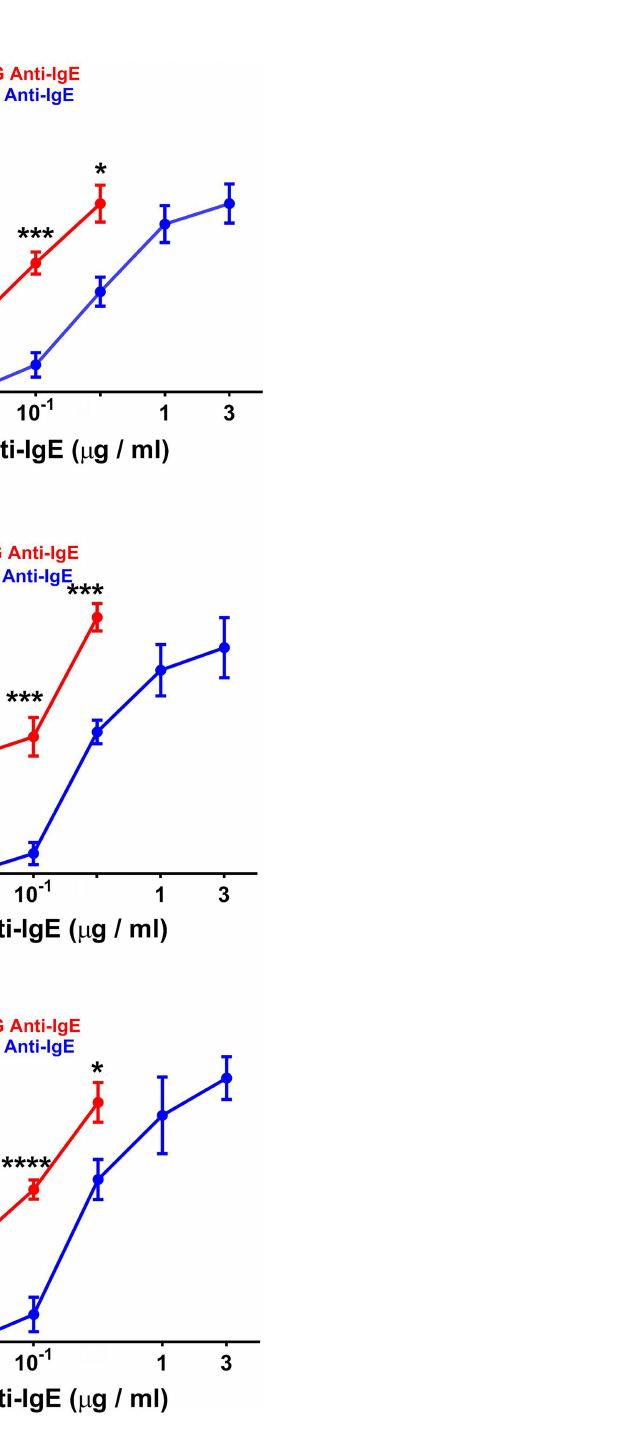
FIGURE 5 | Effects of increasing concentrations of human IgG anti-IgE and rabbit IgG anti-IgE on HR (A) and the de novo synthesis of LTC 4 (B) and PGD 2 (C) from HLMCs obtained from fi ve different donors. HLMCs were incubated (45 min at 37°C) in the presence of the indicated concentrations of human IgG anti-IgE or rabbit IgG anti-IgE. Each point shows the mean ± SEM. **** p < 0.0001, *** p < 0.001, * p < 0.05 when compared to the corresponding value. Error bars are not shown when graphically too